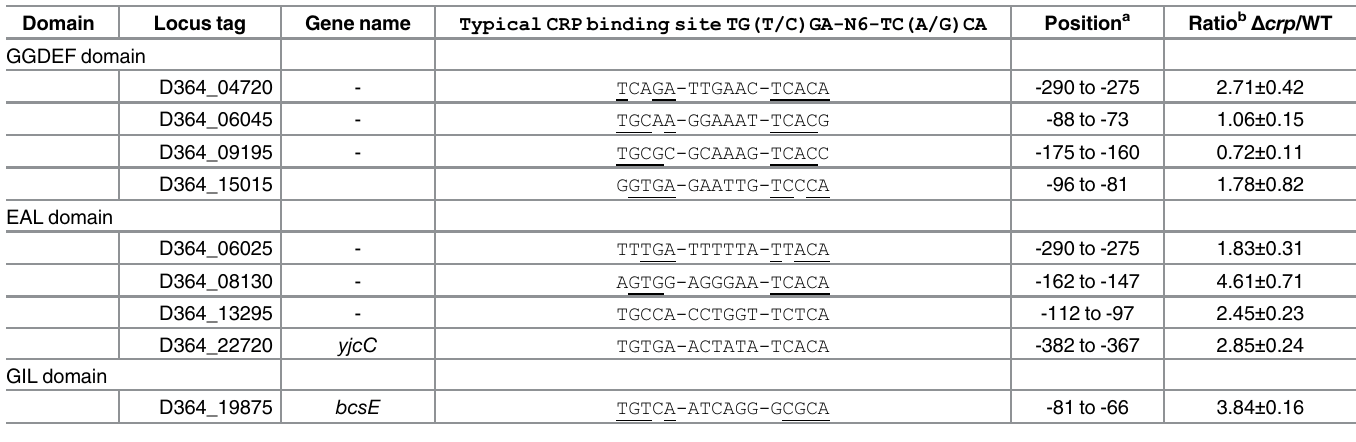
Table 1. Analysis of CRP binding site in the upstream sequences of the c-di-GMP related ORFs in K . pneumoniae CG43 genome.